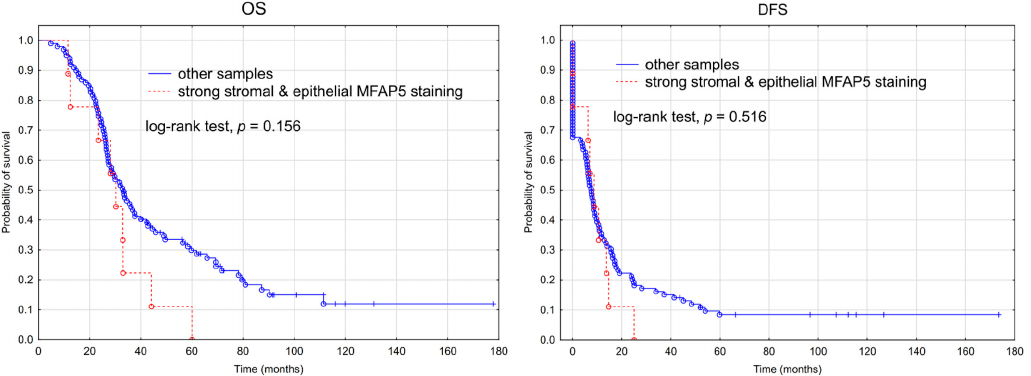
Figure 4. Kaplan-Meier analysis of overall survival (OS) and disease-free survival (DFS) in 108 pa- tients with advanced ovarian cancer stratified by stronger MFAP5 expression (IHC score 2 or 3) both in the stromal and epithelial compartment vs. the rest of samples.